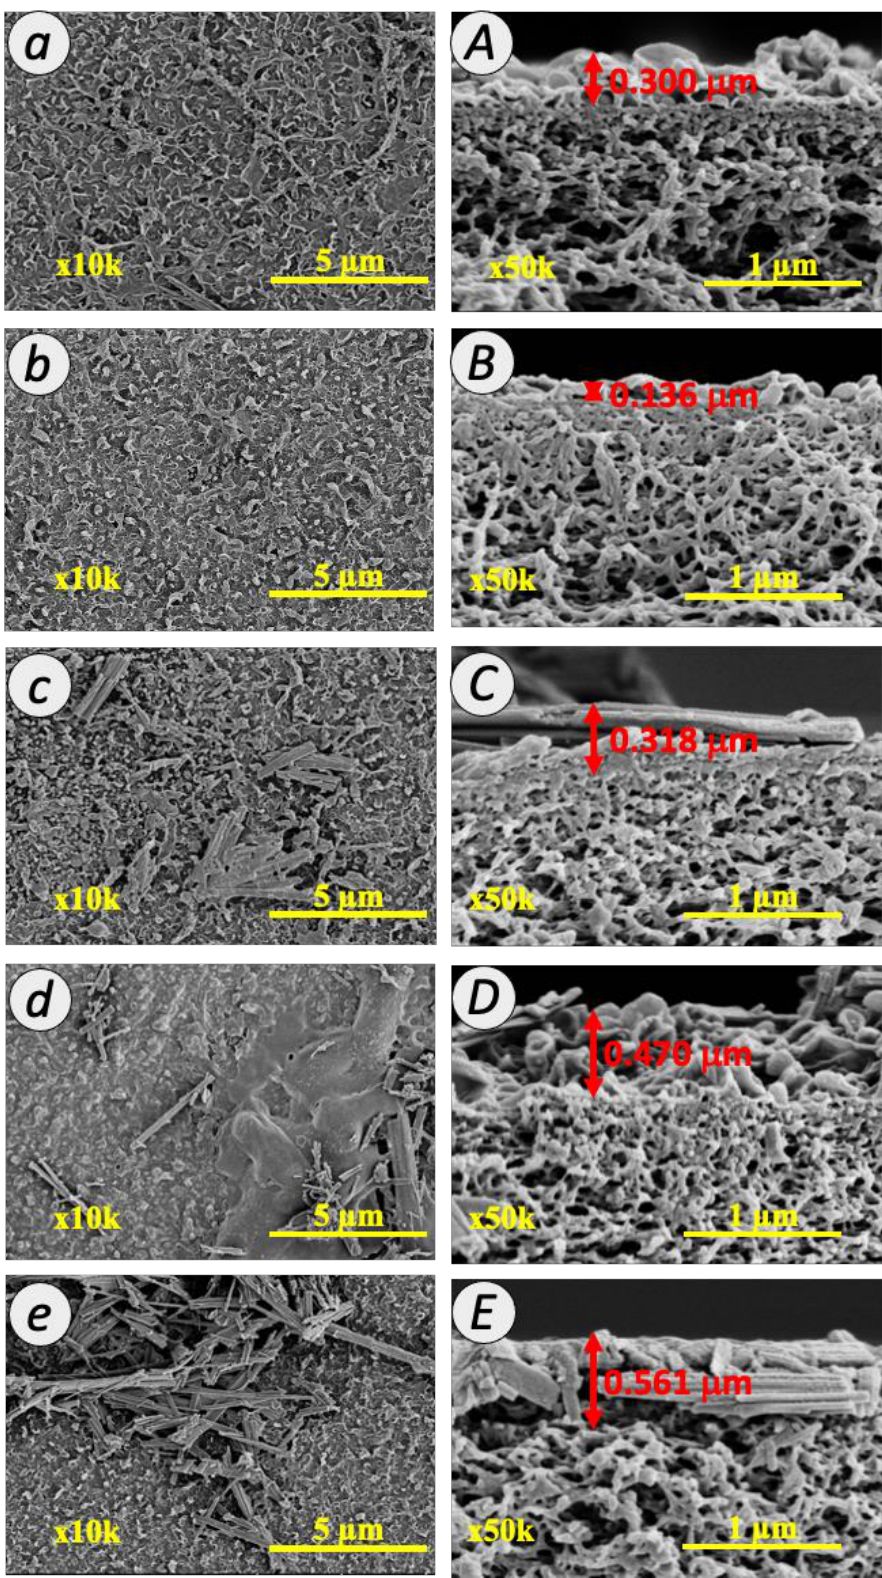
Figure 4. FESEM images for surface ( a – e ) and cross-section ( A – E ) of commercial TFC, TFC, 0.01 TFN, 0.05 TFN and 0.1 TFN membranes at 10 k and 50 k magnifications.